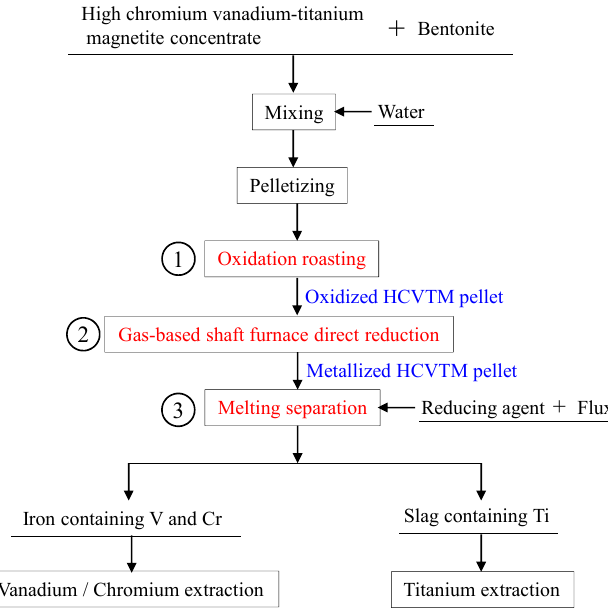
Figure 2. The outline process chart of the novel process for disposing of HVCTM.